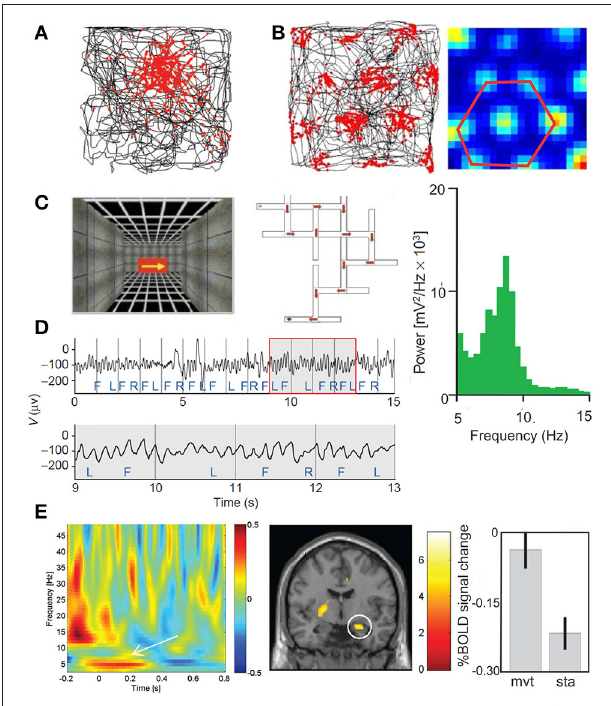
FIGURE 5 | (A) Place cell in the hippocampus (adapted from Moser et al., 2008 , with permission) and (B) grid cell in the medial entorhinal cortex. The locations where the neurons discharge (red) are superimposed on the rat’s trajectory (black) in the recording enclosure black. Whereas, most of the place cells have a single firing location, the of a grid cell form a periodic triangular matrix of the firing fields covering the entire environment available to the animal. (C–E) Theta oscillations revealed by intracranial EEG and MEG in the human. (C) Navigation in virtual reality-rendered multiple T-junction mazes in which key presses move the subject in the VR maze (F, forward; R, right; and L, left). (D) Sample intracranial EEG recorded in the inferior frontal gyrus (upper trace); theta oscillation is emphasizing in an enlarged view of the boxed region (lower trace). The average power in iEEG for one trial through the VR maze during 21 s is represented by the power frequency plot (green) showing a peak in the theta band (4–12 Hz) (adapted from Kahana et al., 1999, with permission). (E) Movement-related MEG time-frequency effects and related fMRI effects. Plots show MEG signal as baseline corrected log normalized difference scores (dB, z axis) against time (x-axis, seconds) and frequency (y-axis, Hz), averaged across 18 participants. The effect of movement initiation during navigation (left panel) is showed at an exemplary single sensor of interest, (posterior right middle temporal location). Coronal slices showing right hippocampal activation for movement initiation compared to stationary periods (middle panel). Percent signal change at right hippocampal peak-voxel averaged across 14 participants for movement and stationary periods (mean 6 SEM) (right panel) (adapted from Kaplan et al., 2012, with